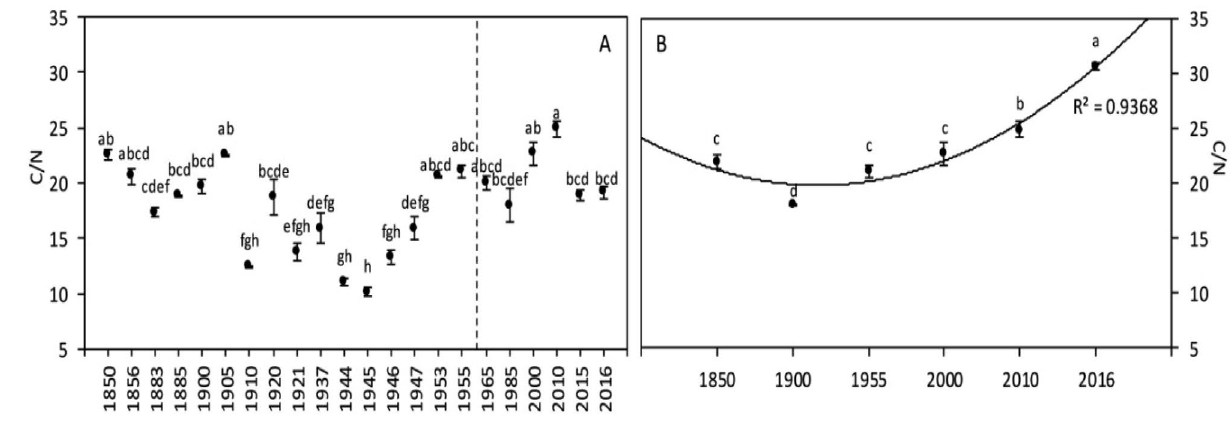
Figure 7. Wheat grain C/N ratio of global ( A ) and Broadbalk experiment ( B ) samples. The dashed line corresponds to the separation between the [1850–1955] and [1965–2016] periods, based on the increase of [CO 2 ]. Data are means ± standard errors (n = 3–14). The same letters indicate no statistically significant differences among years (Fisher’s LSD, p ≥